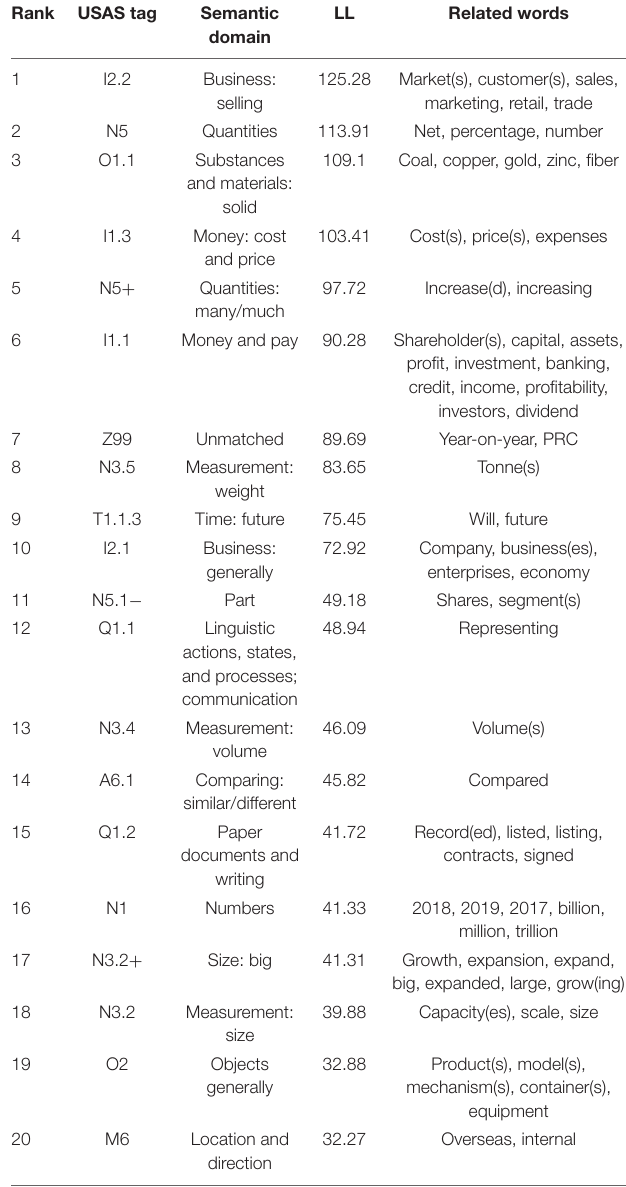
TABLE 4 | Top 20 key semantic domains in the annual report CEO